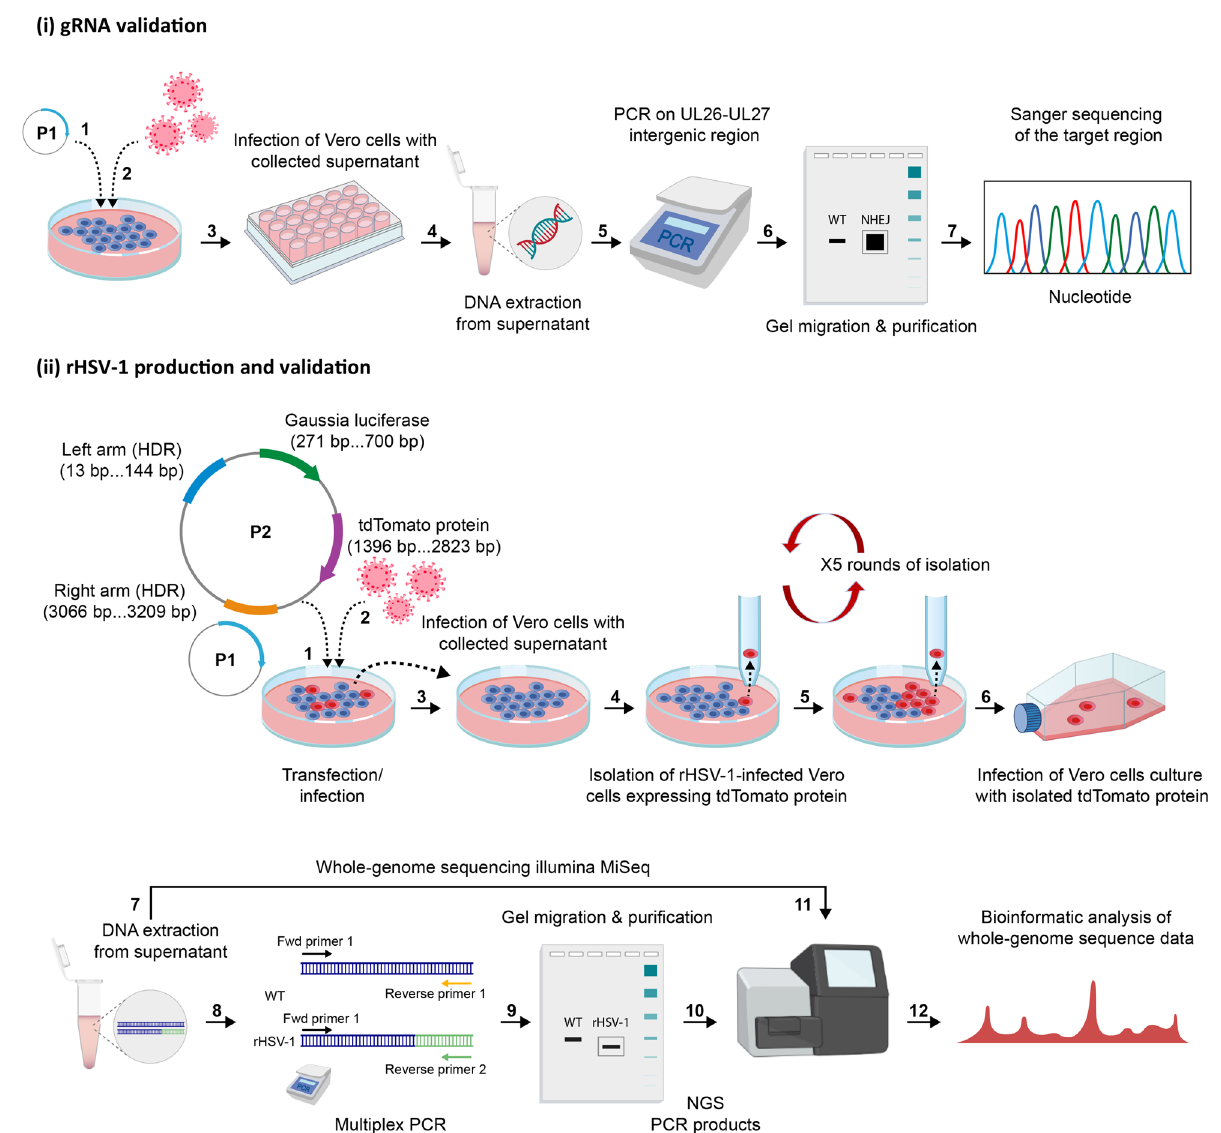
Figure 1. CRISPR-Cas9-mediated generation of recombinant HSV-1 (rHSV-1). Schematic presentation of two workflows: ( i ) gRNA validation and ( ii ) rHSV-1 production and the validation. ( i ) gRNA validation: Following the transfection/infection step (P1: CRISPR-Cas9 vector/ HSV-1 strain H25), collected supernatants were diluted and used to infect naïve Vero cells. Supernatant was collected and viral DNA was amplified. PCR products from the amplification of UL26-UL27 intergenic region were first gel-purified, then Sanger sequenced for NHEJ-mediated indel mutation analysis. ( ii ) rHSV-1 production and validation: Following the transfection/ infection step (a mixture of plasmids (P1: CRISPR-Cas9 vector and P2: The HDR (homology-directed repair) donor plasmid)/HSV-1 H25 strain), collected supernatants were used to infect naïve Vero cells. tdTomato + rHSV-1 infected cells were isolated and used to infect naïve Vero cells. Five rounds of isolation/infection process were performed to eliminate all WT HSV-1 virions from rHSV-1 viral production. Supernatant was collected and DNA extraction was performed. PCR products from multiplex PCR were gel-purified. Two viral DNAs (WT HSV-1 H25 strain, rHSV-1) and gel-purified Multiplex PCR products were deep-sequenced by using Illumina MiSeq. Bioinformatic analysis was performed for whole-genome construction of both viruses. Images were created using Adobe Illustrator (version 25.3.1/https:// www. adobe.